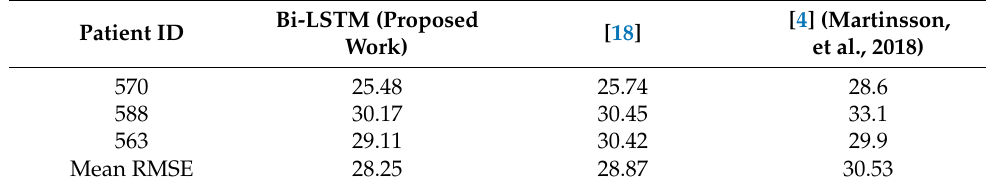
Table 6. Comparison of prediction RMSE with other studies at prediction horizon of 60